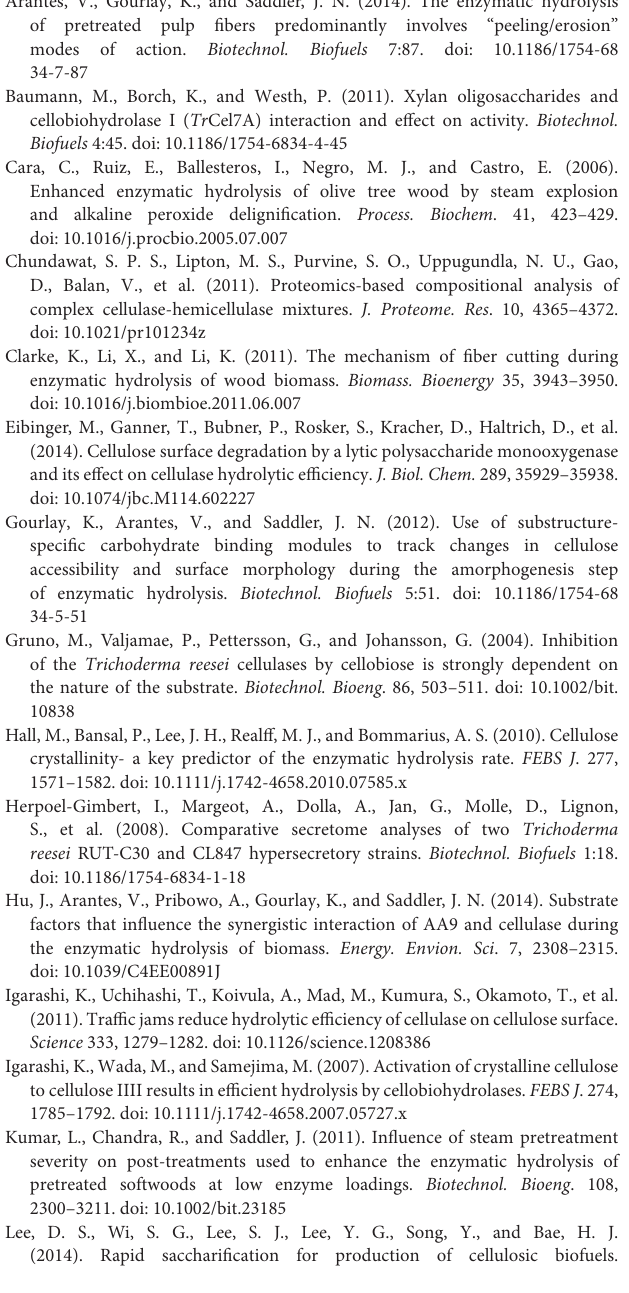
The fibers were monitored using a microscope (Eclipse TE2000-U, Nikon). a , 0min; b , 40min; c , 120min; d , 180min. Supplementary Figure 2 | The fraction of wood and tracheid fibers contains vessel elements such as large vessel member (A) and elongated vessel member (B) . The vessel elements were monitored to compare with the degradation rate of wood fibers. The vessel elements were observed to be degraded faster than tracheid and wood fiber. The hydrolysis was carried out with 15 FPU mL − 1 at 50 ◦ C. a , 0min; b , 10min; c , 20min. f , wood fiber; tr , tracheid; v , vessel